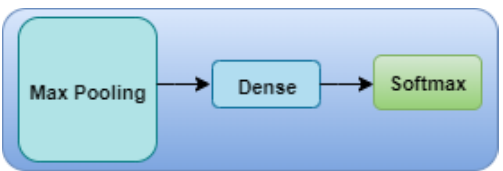
Figure 9. Architecture of the classification block.